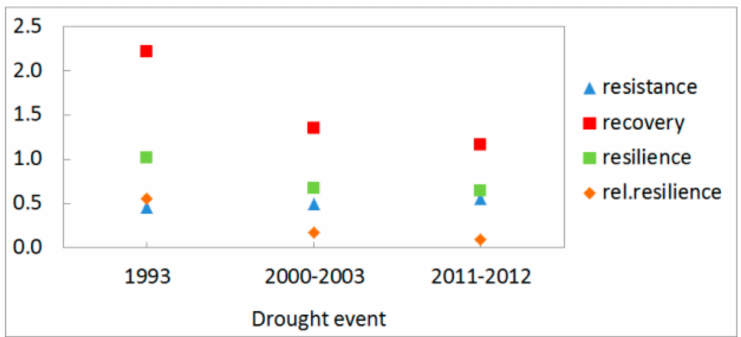
Figure 11. Drought reaction for the four drought response measures